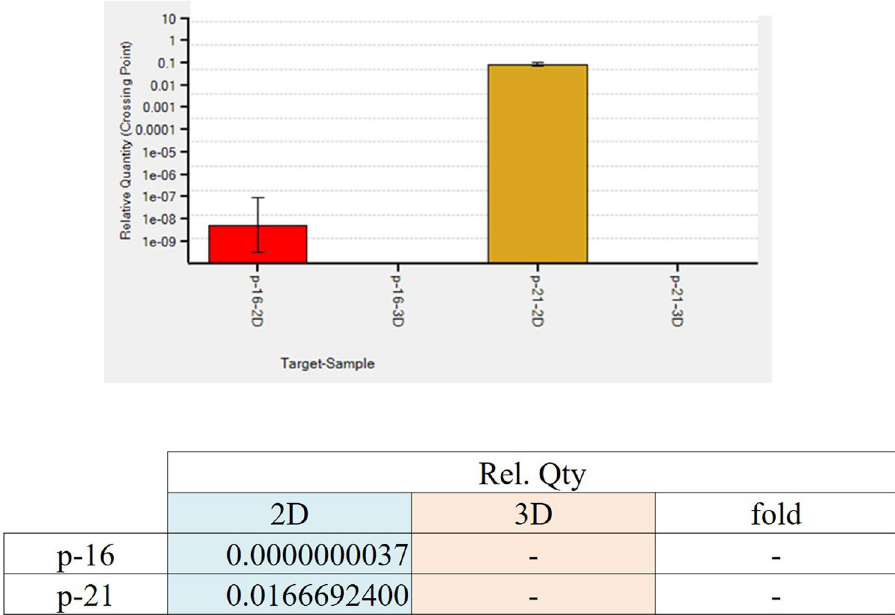
Figure 3. Relative expression of p16 INK4a and p21 only in 2D cultured chondrocytes and not in 3D-TGP indicating presence of senescent cells in 2D cultures but not in 3D-TGP.